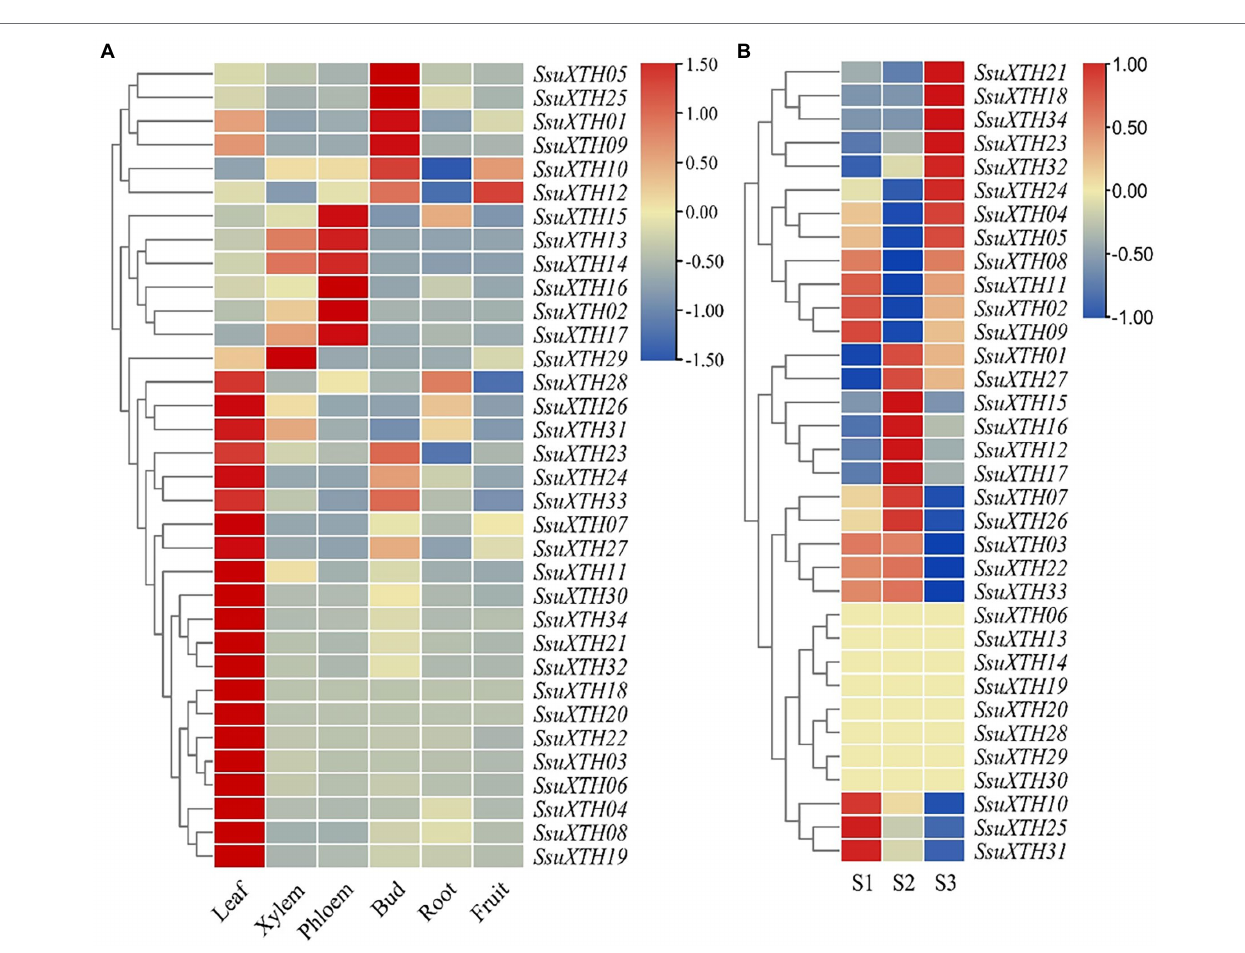
FIGURE 5 | Expression profiles of SsuXTHs in different tissues and materials with different vascular characteristics. (A) The leaves, phloem, xylem, buds, roots and fruits were collected and then used for qRT-PCR. The expression level was calculated according to the 2 −∆∆Ct method. Relative mRNA abundance of each gene was normalized with SsuACT gene. (B) RNA-seq data of three half-sib progenies (S1, S2 and S3) from SC25 family in S. superba with different vascular characteristics were used for expression profiles analysis. The expression level was determined by the FPKM calculated by StringTie v2.1.2 tool and log2 transformation was used for